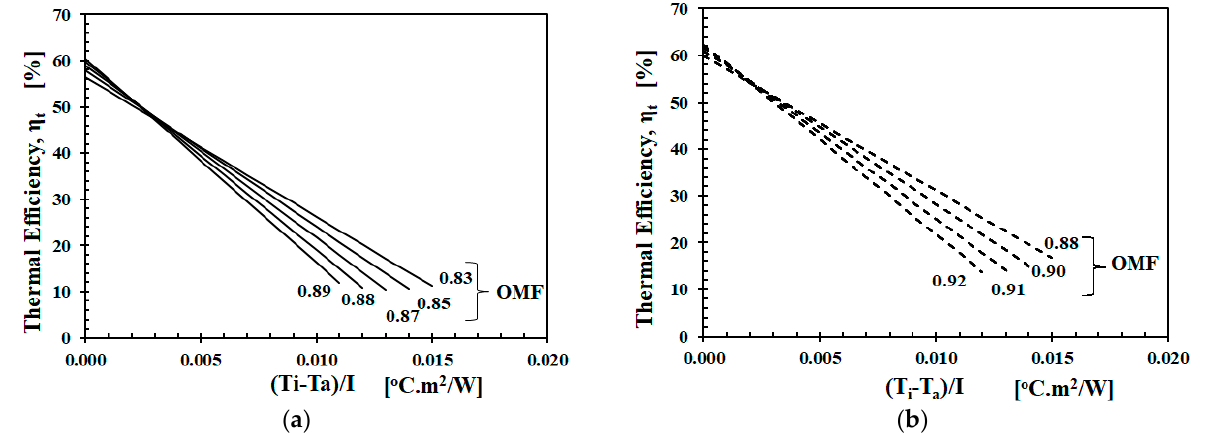
Figure 7. Simulation of thermal efficiency vs. reduced temperature: ( a ) Without wind loss effect; ( b ) wind loss effect. ( b ) wind loss